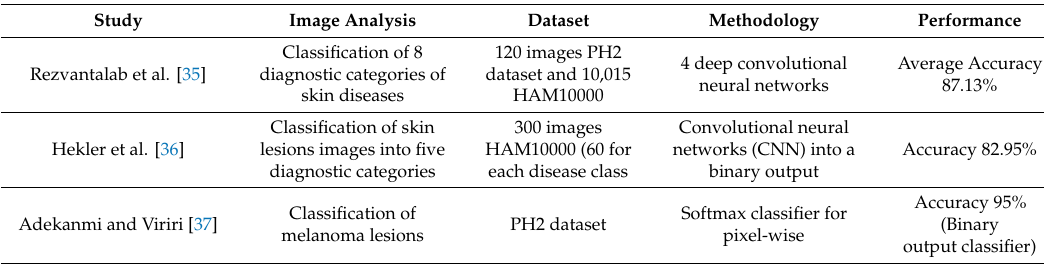
Table 1. A comparison of the current related